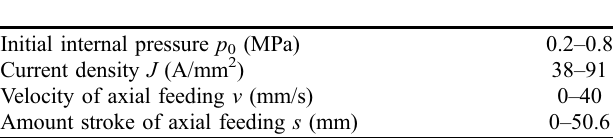
Table 1. Conditions of hot bulging